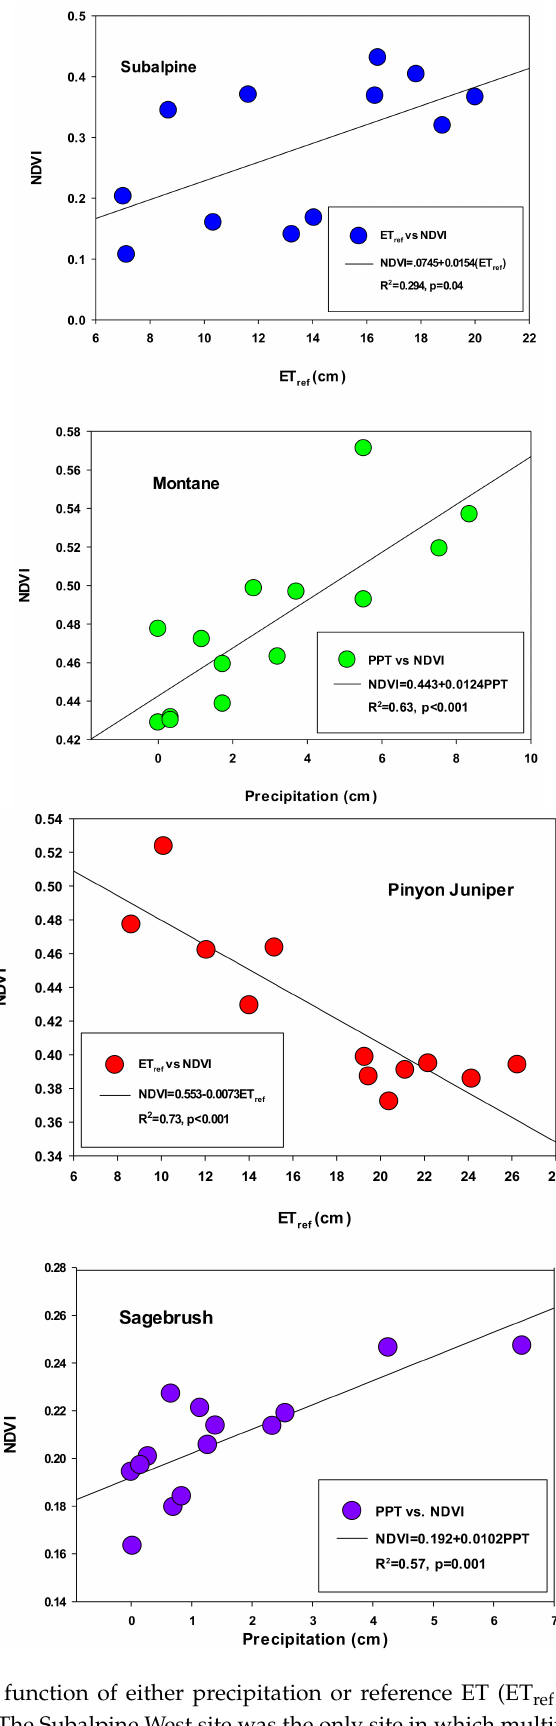
Figure 8. NDVI as a function of either precipitation or reference ET (ET ref ) at each site (highest correlation reported). The Subalpine West site was the only site in which multiple regression analysis (i.e., with both precipitation and ET ref ) achieved a higher correlation (R 2 = 0.70, p <